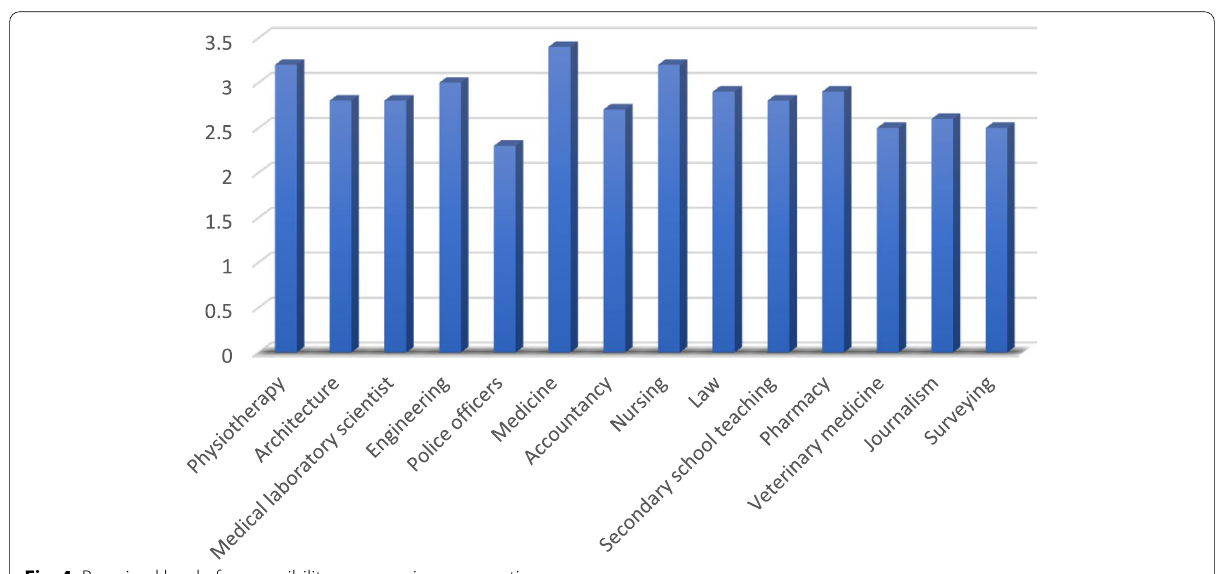
Fig. 4 Perceived level of responsibility across various